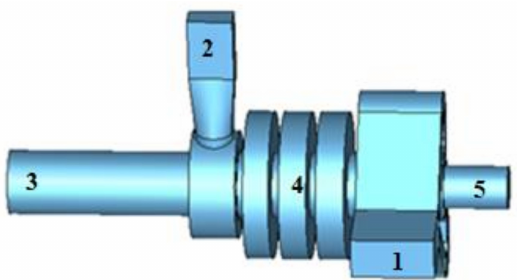
(cid:3) in K-band, 1,1